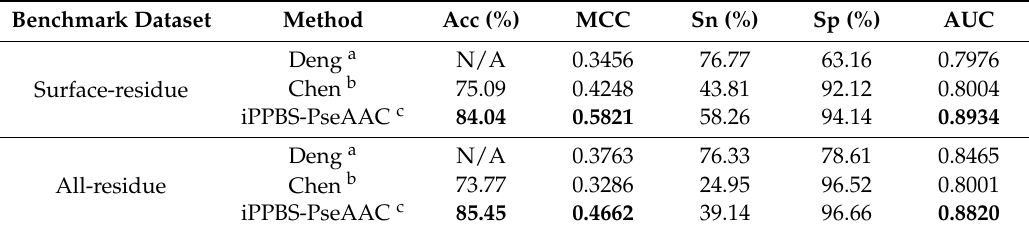
Figure 4. A plot of Acc vs. K for ( a ) the surface-residue benchmark dataset ( cf. Equation (4)); and ( b ) the all-residue benchmark dataset ( cf. Equation (5)). It can be seen from panel ( a ) that the overall accuracy reaches its peak at K “ 9, and from panel ( b ) that the overall accuracy reaches its peak at K “ 15 . Table 3. Comparison of the iPPBS-Opt with the other existing methods via the 10-fold cross-validation on the surface-residue benchmark dataset (Equation (4)) and the all-residue benchmark dataset (Equation